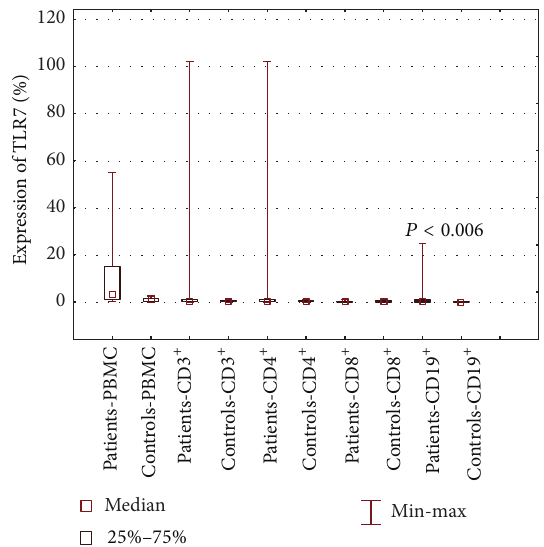
Figure 4: The percentage of PBMCs, lymphocytes B CD19 + , and lymphocytes T CD3 + , including CD4 + and CD8 + , expressing TLR7 in patients with SLE and healthy